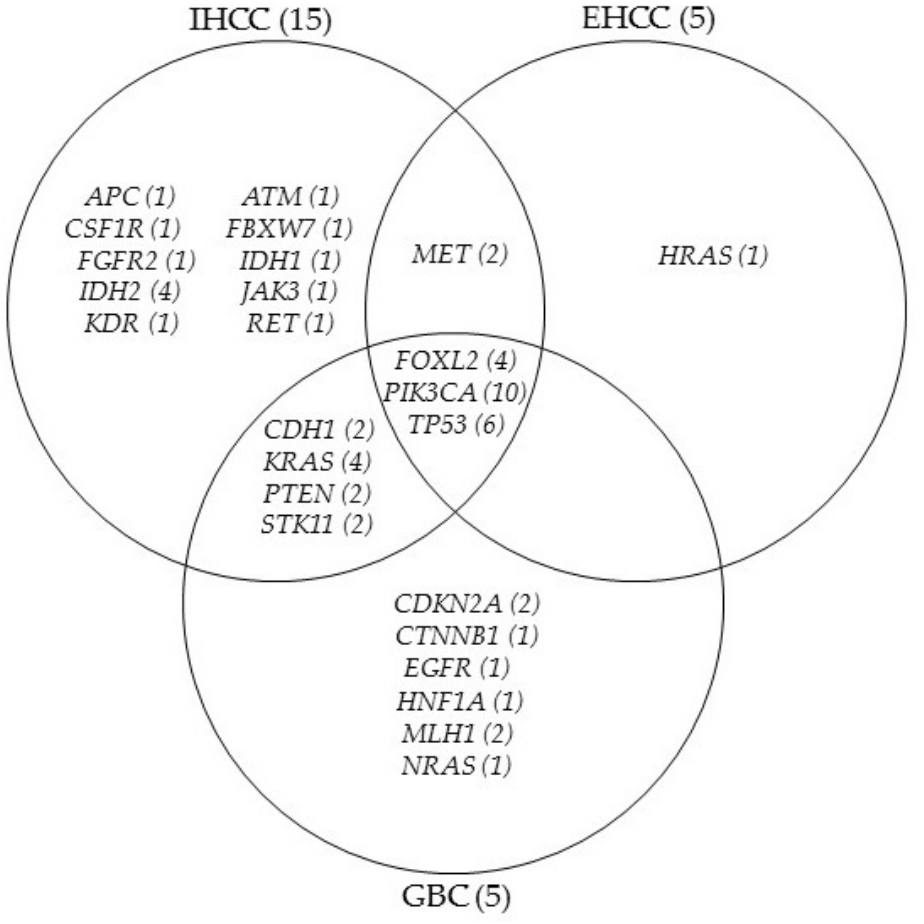
Figure 4. Genetically aberrant gene distribution of the three subtypes of BTCs. IHCC (15): intrahepatic cholangiocarcinoma, EHCC (5): extrahepatic cholangiocarcinoma, GBC (5): gallbladder carcinoma (case number are in bracket). Gene aberration frequencies are presented in the bracket after gene symbols.